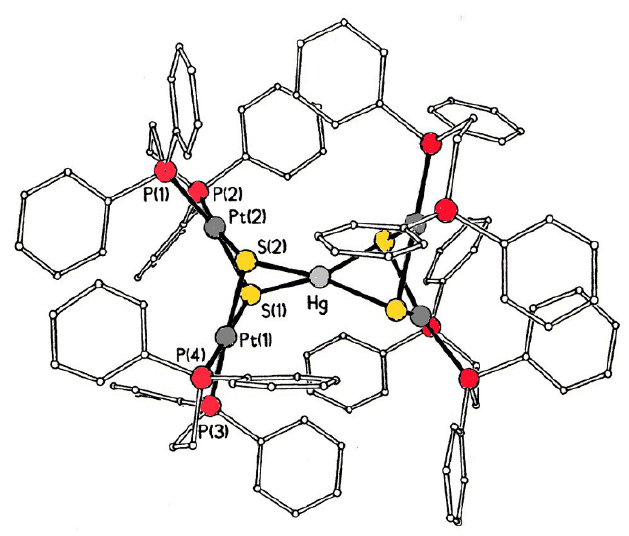
Figure 1. [{( η 2 -dppe)